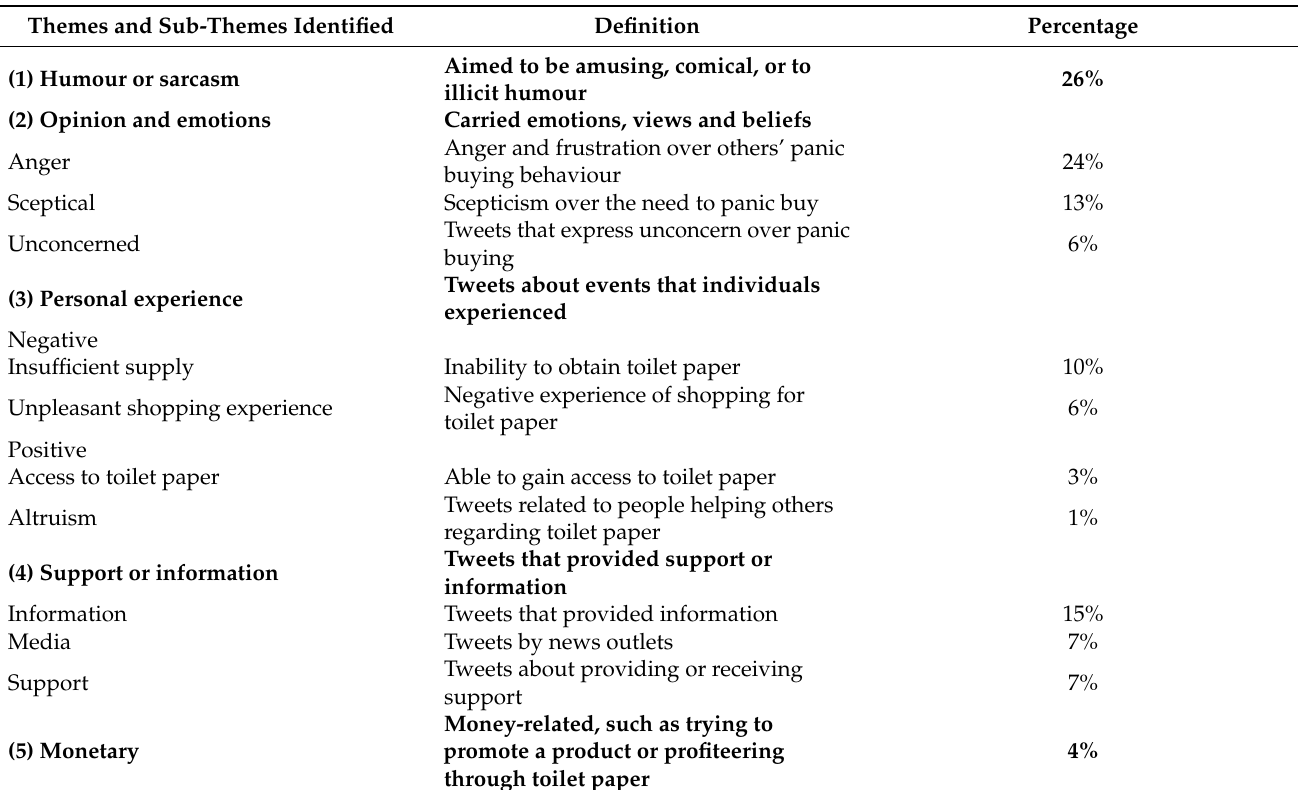
Table 3. Themes, with counts, and stats of